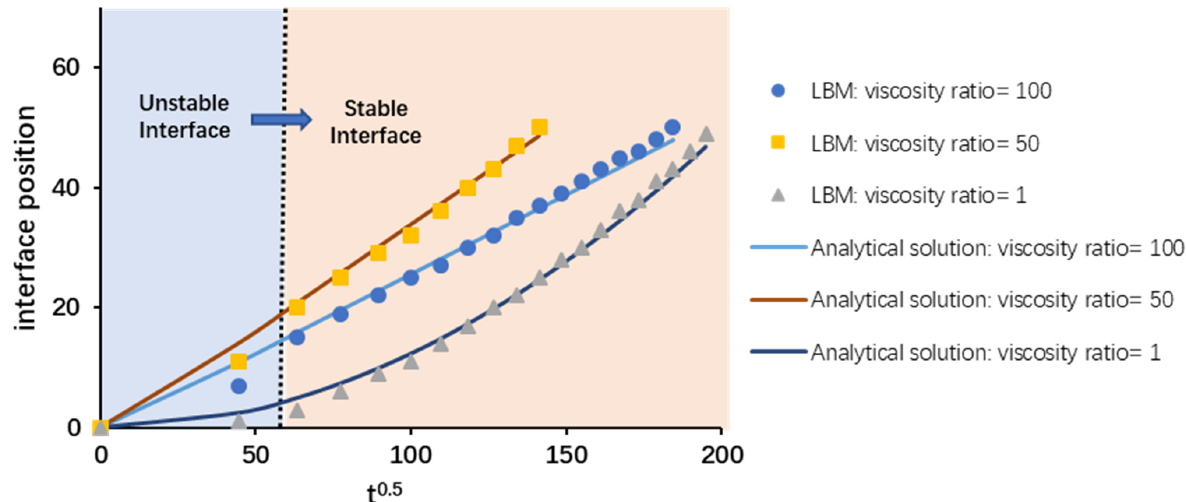
Figure 8. Simulation of spontaneous imbibition in a simple capillary for different viscosity ratios.